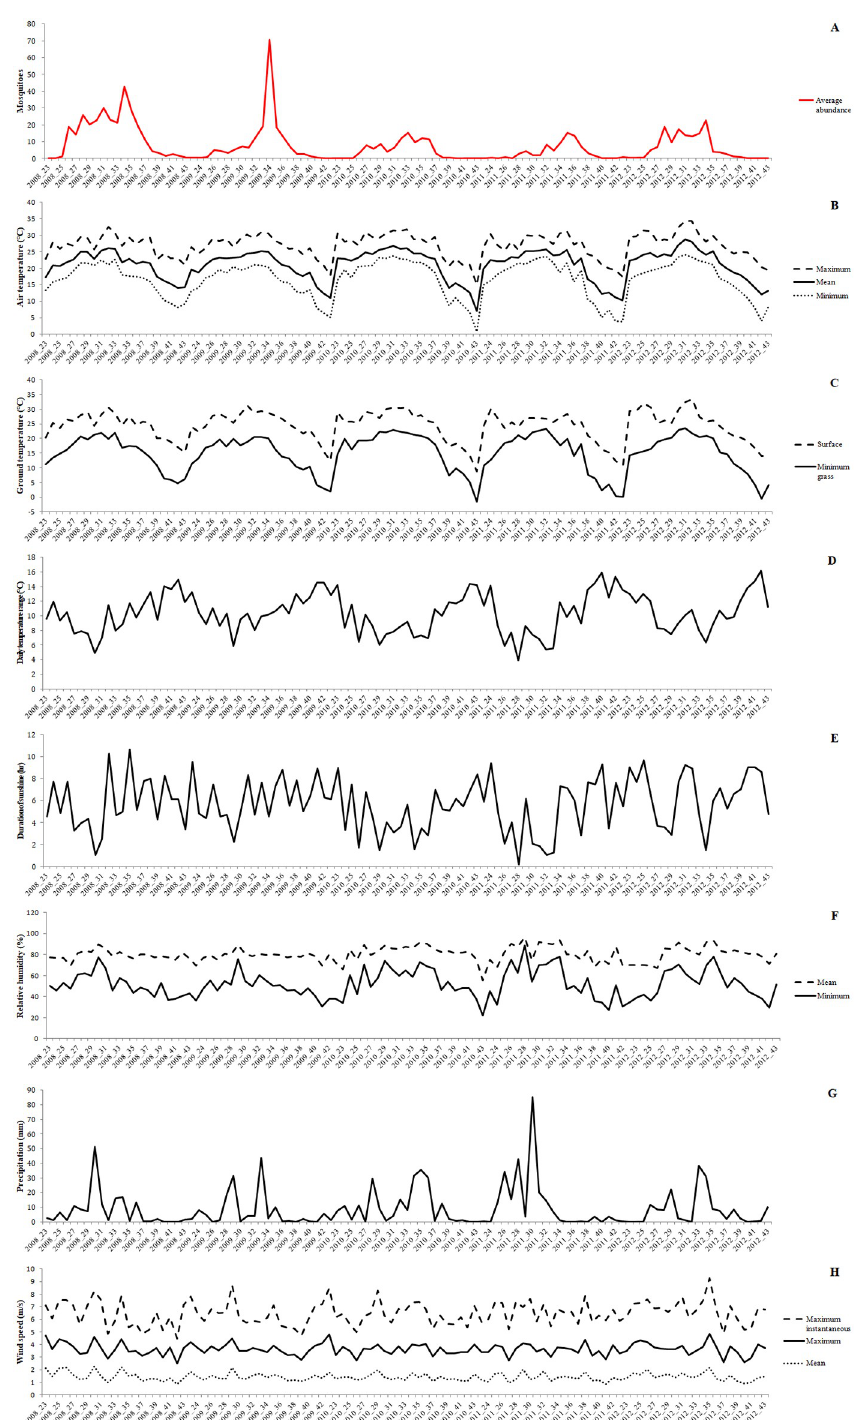
Fig 2. Time series plots of weekly Anopheles sinensis average abundance from 2008 to 2012 in Goyang, Korea. A: Mosquito average abundance, B: Air temperature (˚C), C: Ground temperature (˚C), D: Daily temperature range (˚C), E: Duration of sunshine (h), F: Relative humidity(%), G: Precipitation (mm), H: wind speed (m/s).